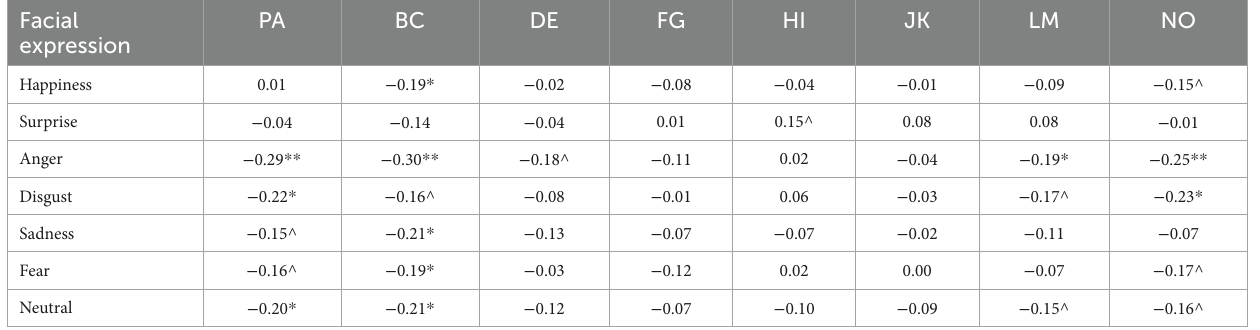
TABLE 4 Correlations between IIP scales and recognition of emotional facial expressions (unbiased hit rates). Facial